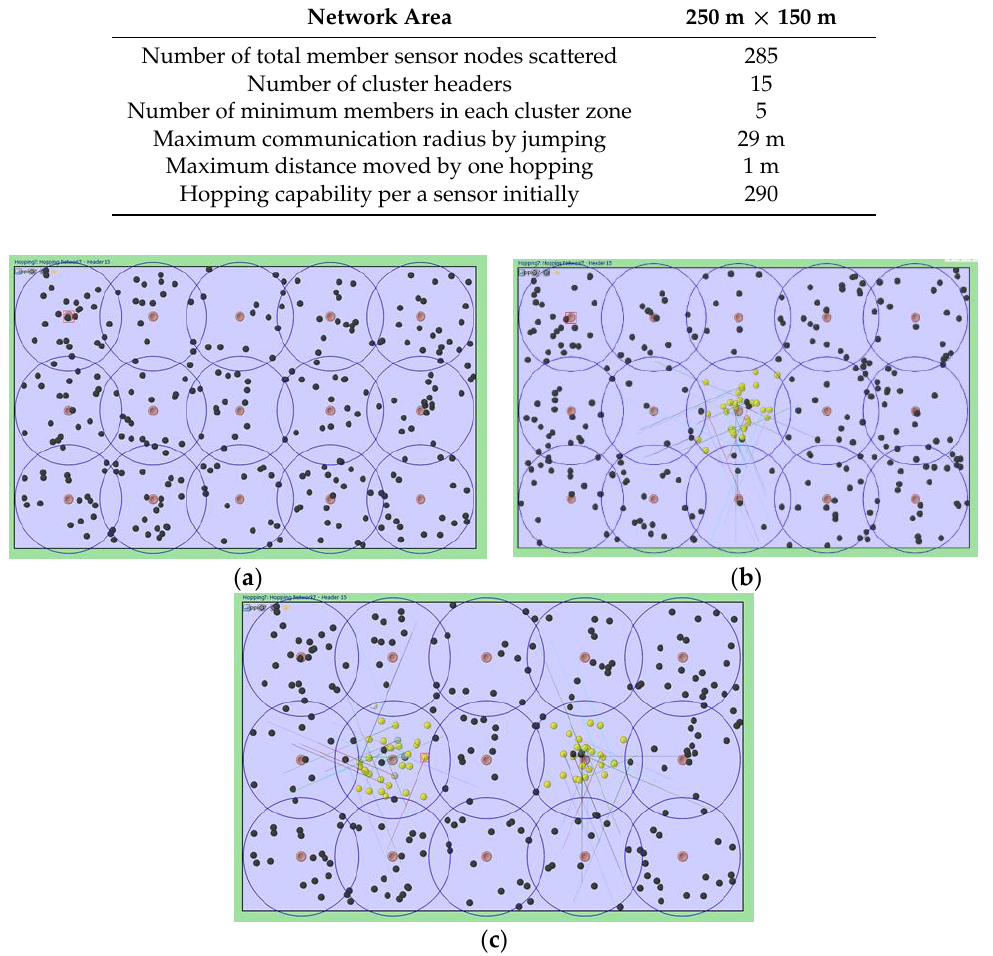
Figure 11. The wireless sensor network environment and examples for when sensing holes occur: ( a ) The hopping sensors are scattered, the cluster zones are configured, and the cluster headers are set up; ( b ) a single sensing hole occurred; and ( c ) two sensing holes occurred.